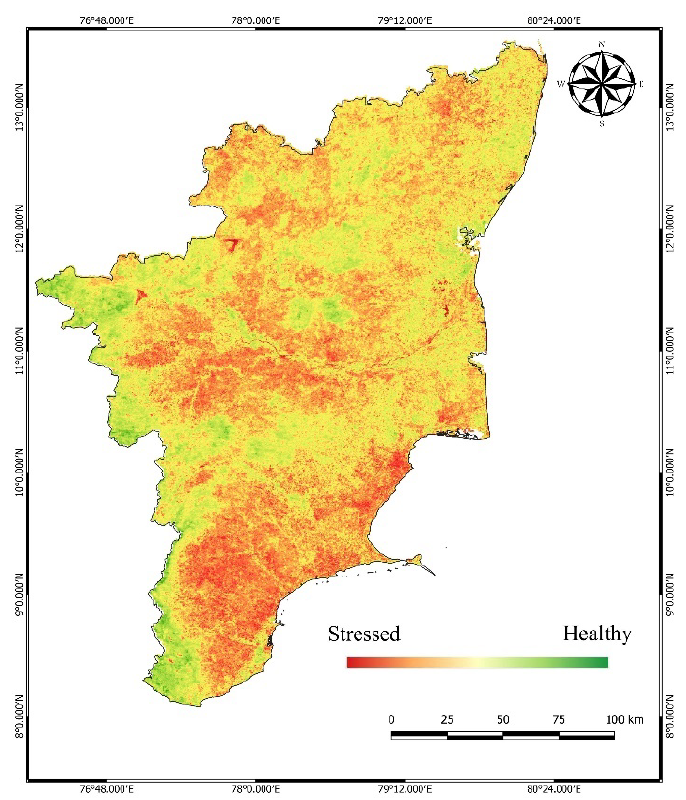
Figure 8. Analyzing the vegetation health in 2020 using VHI for Tamil Nadu.